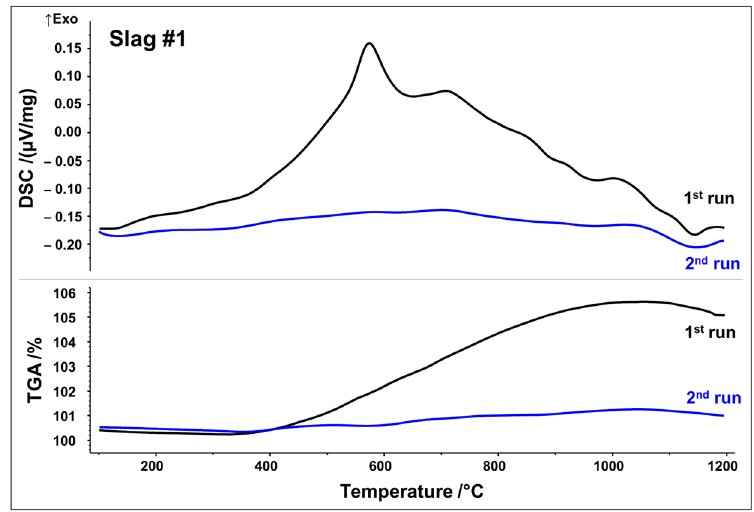
Figure 3. DSC/TGA analysis of slag 1; heating rate 10 K/min.